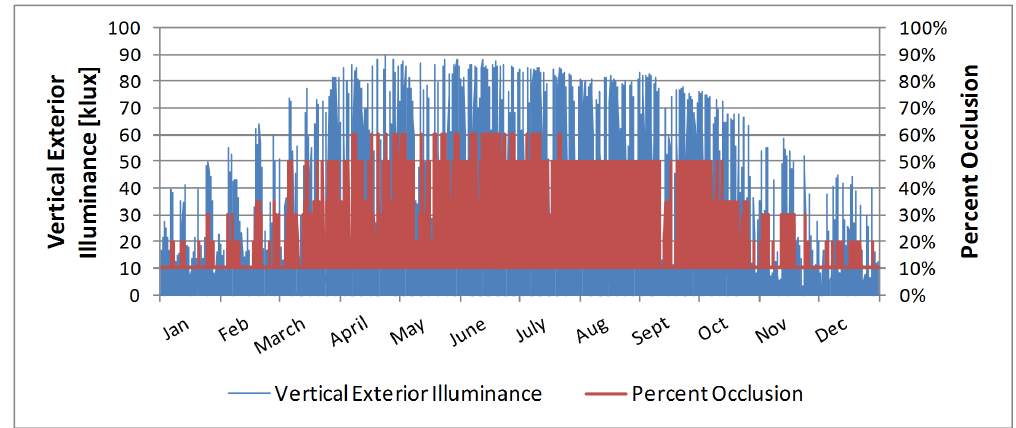
Figure 14. Annual vertical exterior illuminance vs. percent occlusion for the east facade first floor (Blindswitch B).